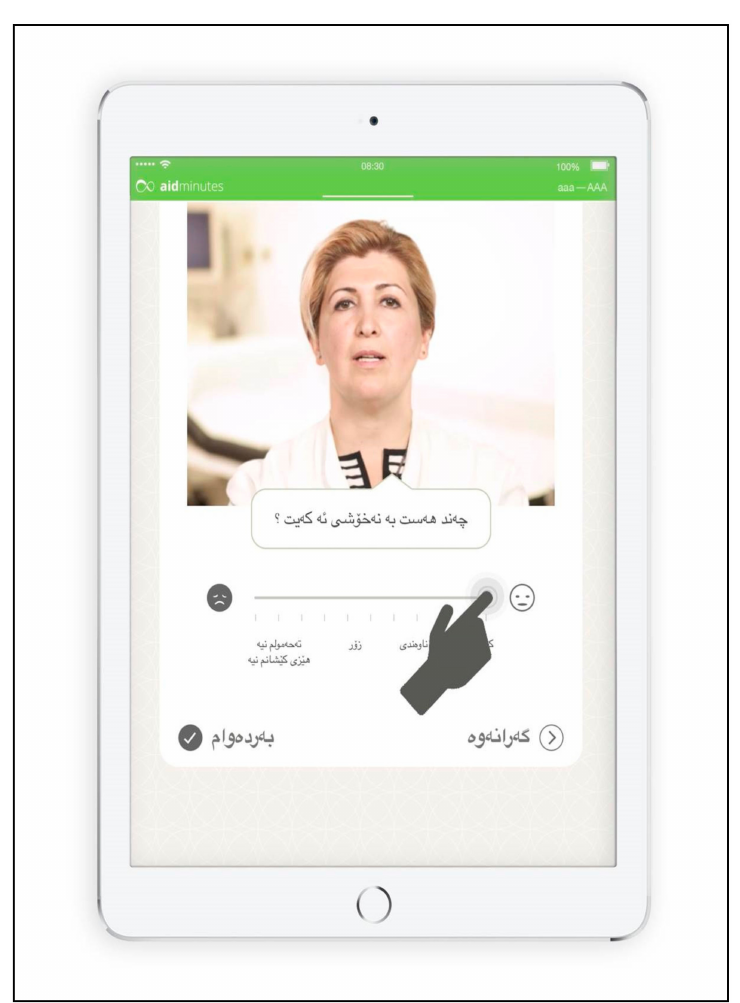
Figure 1. In-app tutorial in the Kurdish Sorani version showing how to use the analog scale control. In the video the user is asked: “How severe are your complaints?” The slider element, as well as the proceed and backward buttons, are adapted to the reading direction (right to